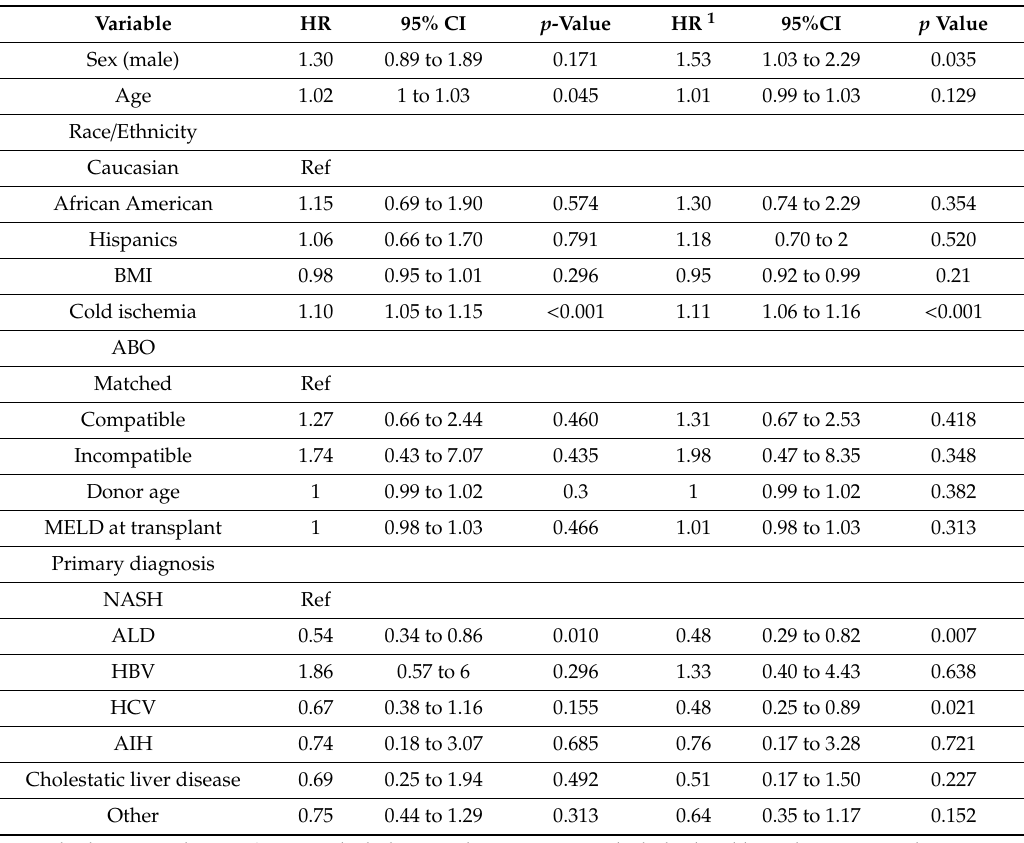
Figure 1. Unadjusted Kaplan–Meier estimates comparing graft survival (composite of post-transplant death and re-transplant by race/ethnicity). Table 2. Multivariate Cox regression analysis of graft survival (composite of post-transplant death and re-transplantation).